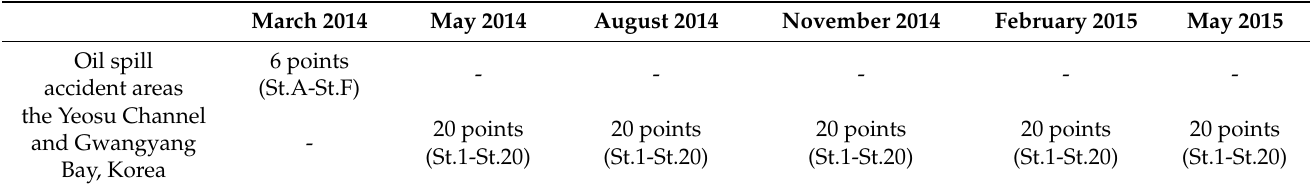
Table 1. Summary of the sampling to collet PAHs samples in the subtidal zone in the Wu Yi San oil spill site and in the Yeosu Channel and Gwangyang Bay,